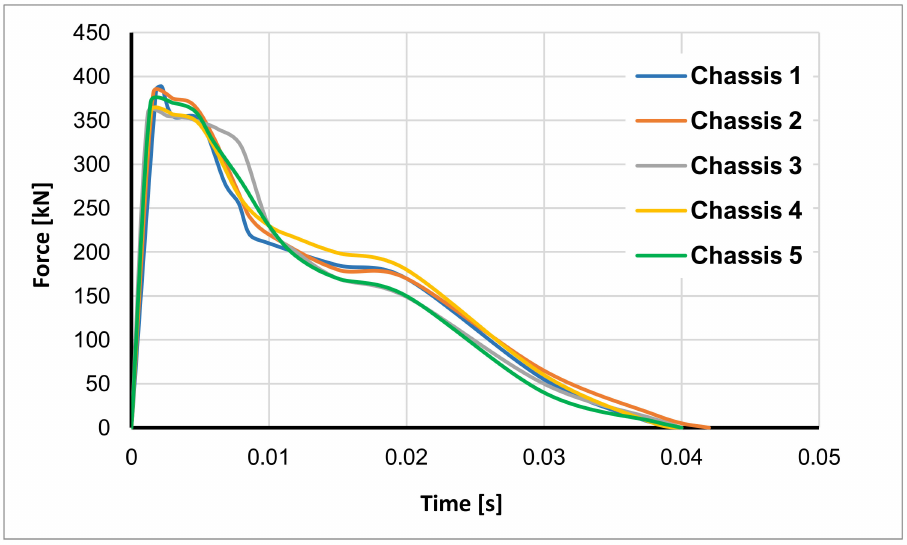
Figure 13. Force-time